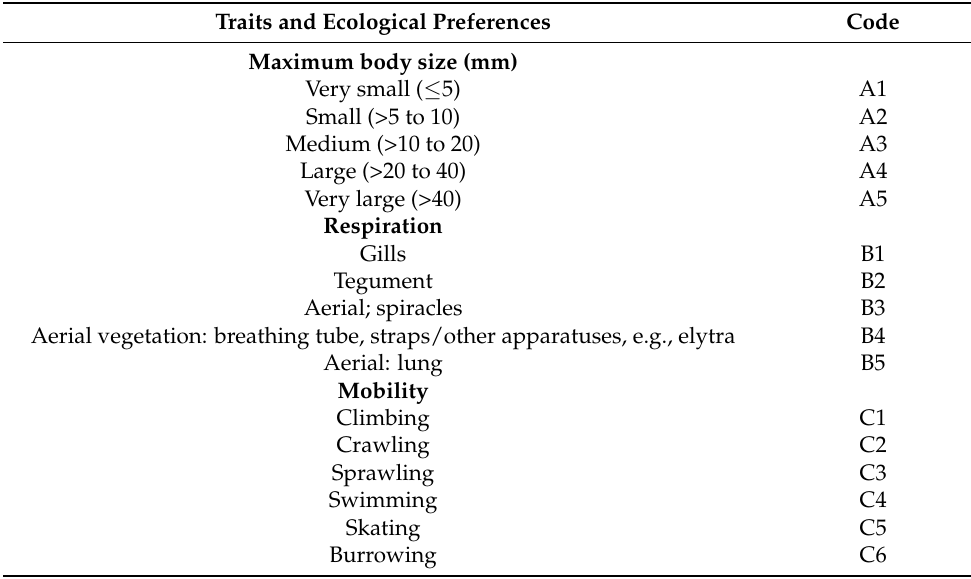
Table 1. Selected macroinvertebrates ecological preferences and traits, as well as their respective attributes. Abbreviations; FPOM (fine particulate organic matter), CPOM (coarse particulate organic matter) and GSM (gravel, sand, and mud) (Table was adapted from [8]).